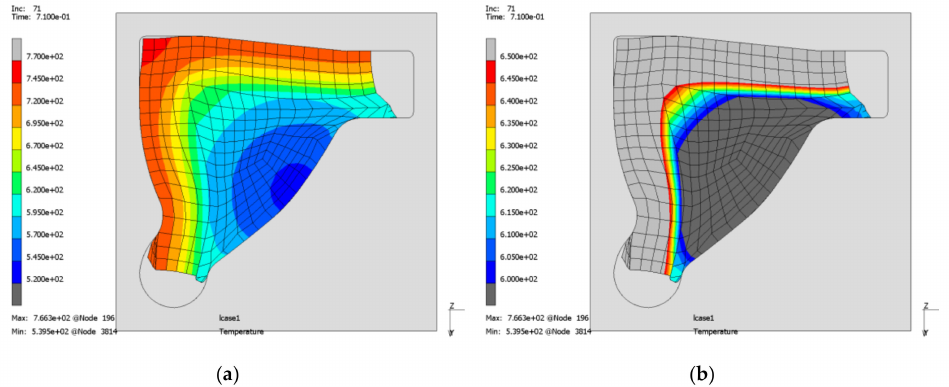
Figure 14. Forming process using a further simplified geometry; whole ( a ) and adapted temperature range ( b ): temperature